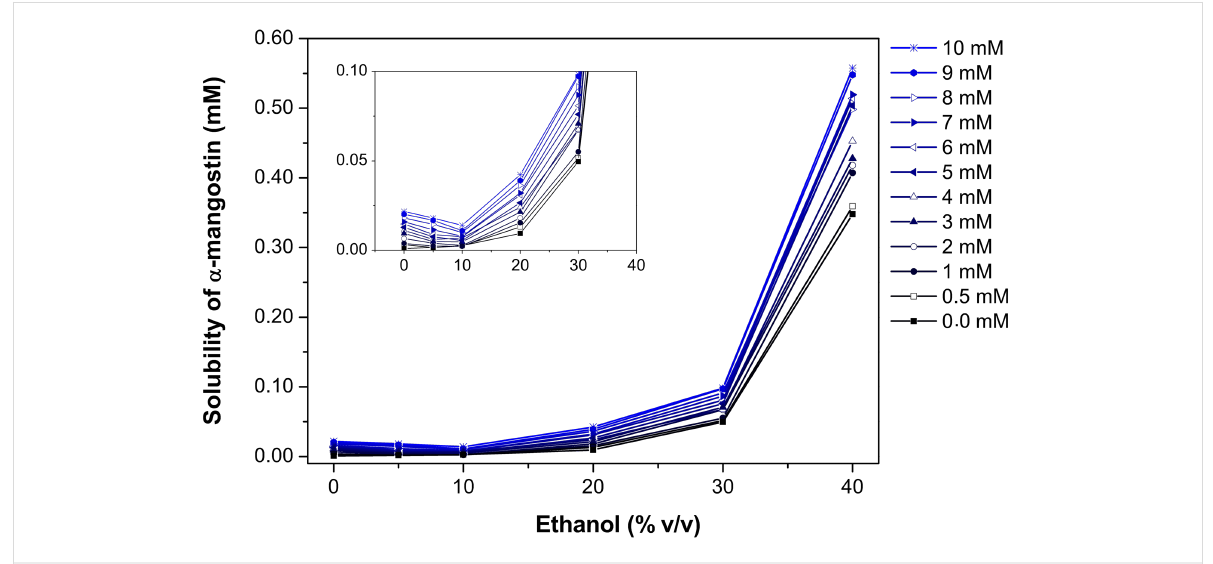
Figure 2: Solubility of α -mangostin as a function of ethanol concentration for different β -CD concentrations.